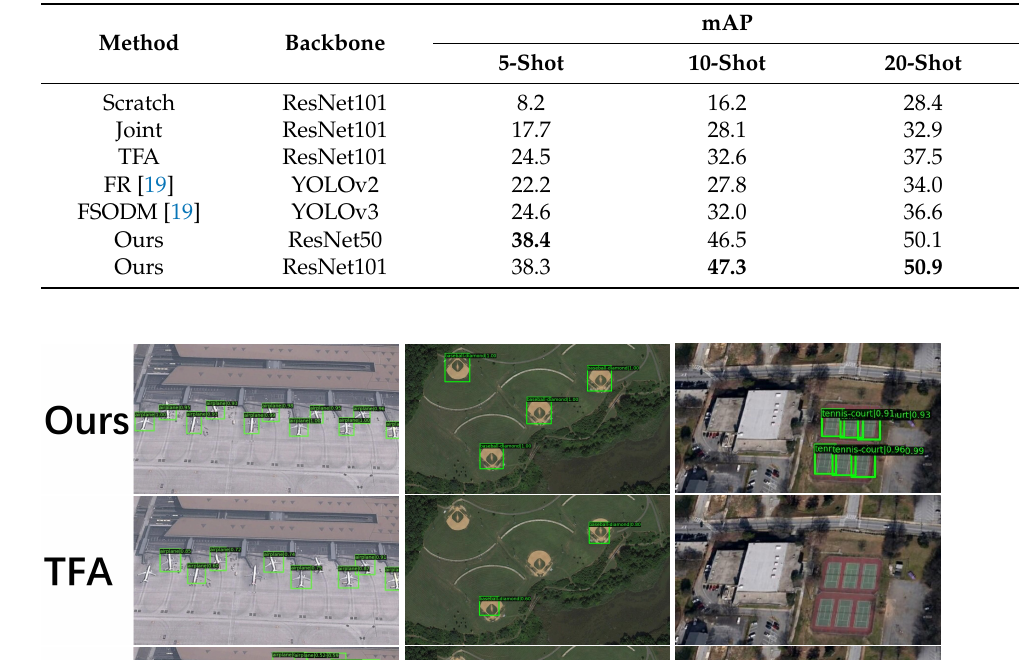
Table 2. Few-shot detection performance on novel classes of the DIOR dataset.